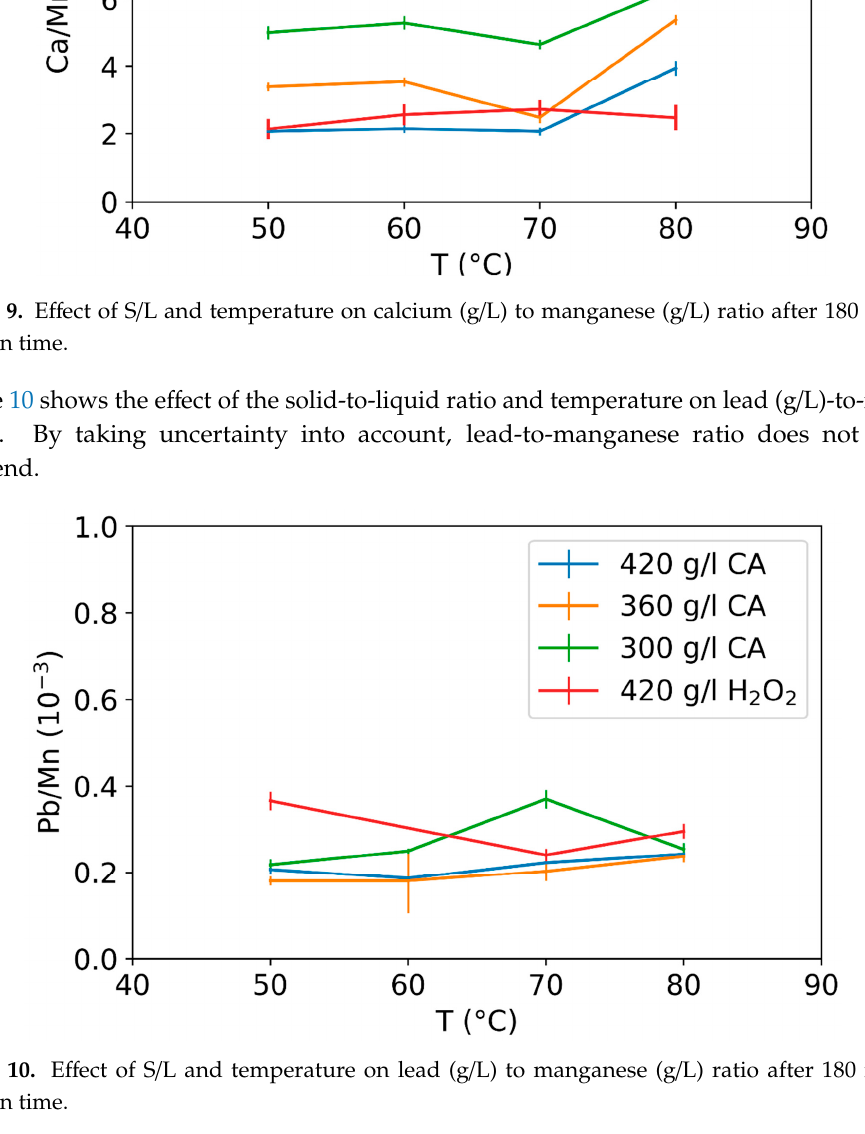
reaction Figure 10. Effect of S/L and temperature on lead (g/L) to manganese (g/L) ratio after 180 min of reaction time.